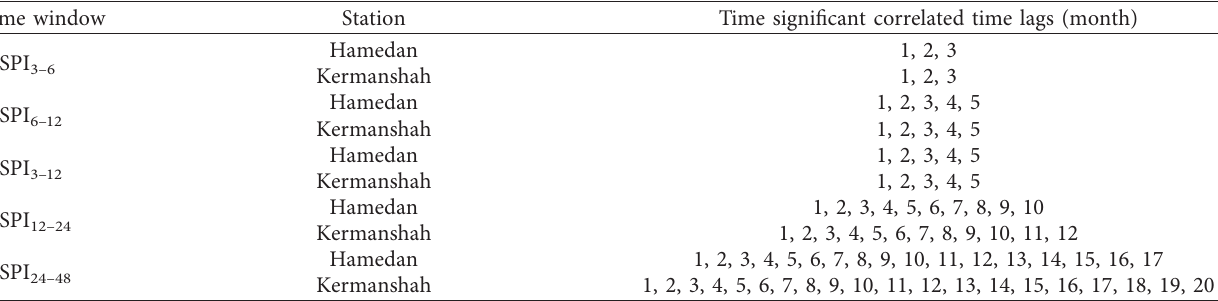
Table 3: Time lags of MSPI as inputs selected by ACF.